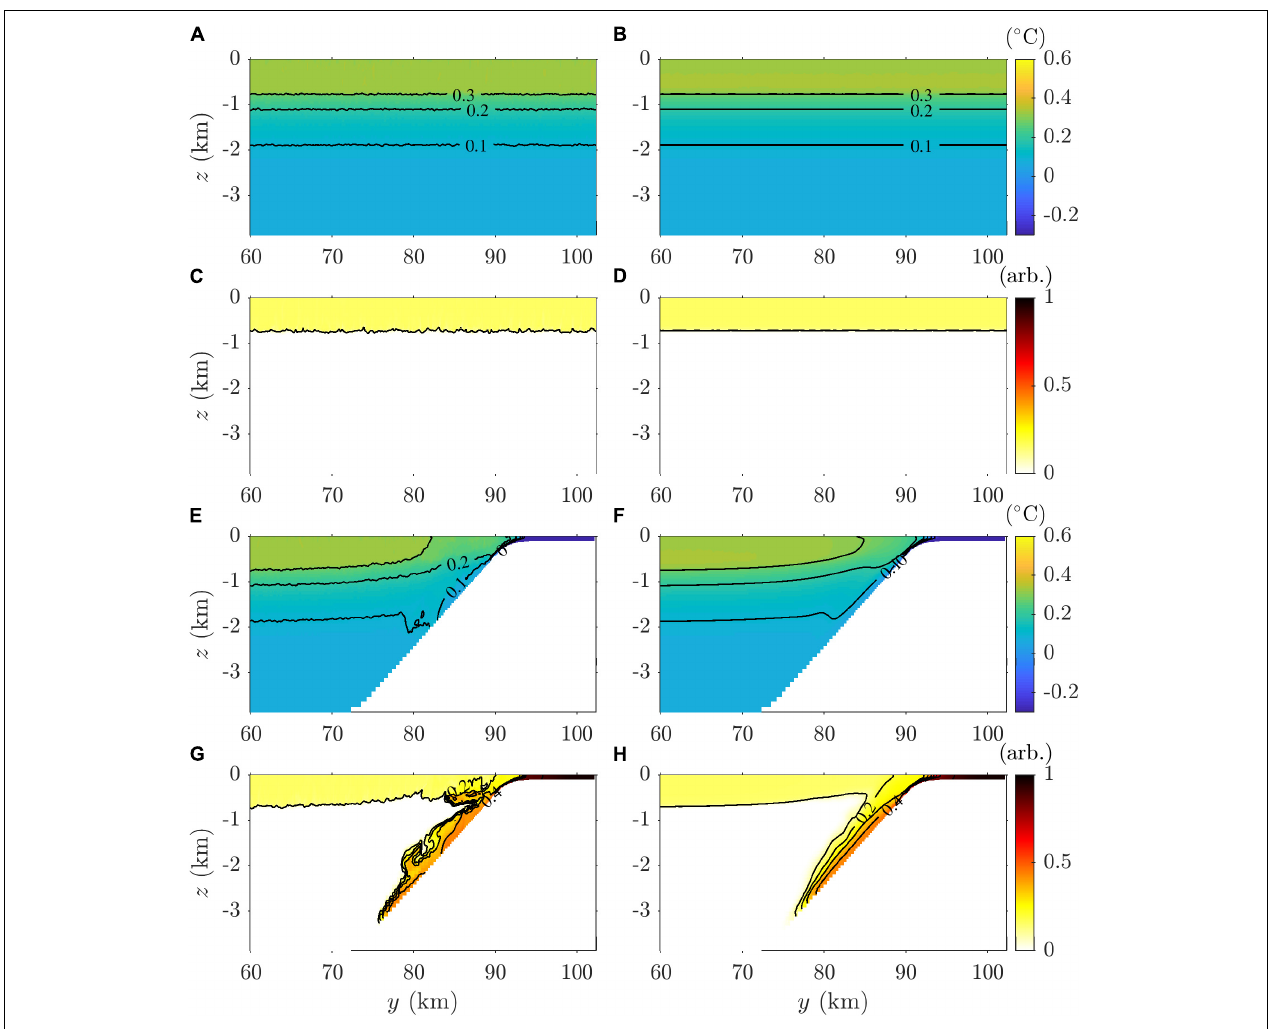
FIGURE 4 | Meridional sections of the (A,B,E,F) potential temperature and (C,D,G,H) tracer concentration from the (A–D) OO and (E–H) SCS experiments. Left panels (A,C,E,G) are cross-sections at x = 25.6 km at the end step of day 20, and right panels (B,D,F,H) are zonally and temporally averaged values on day 20.